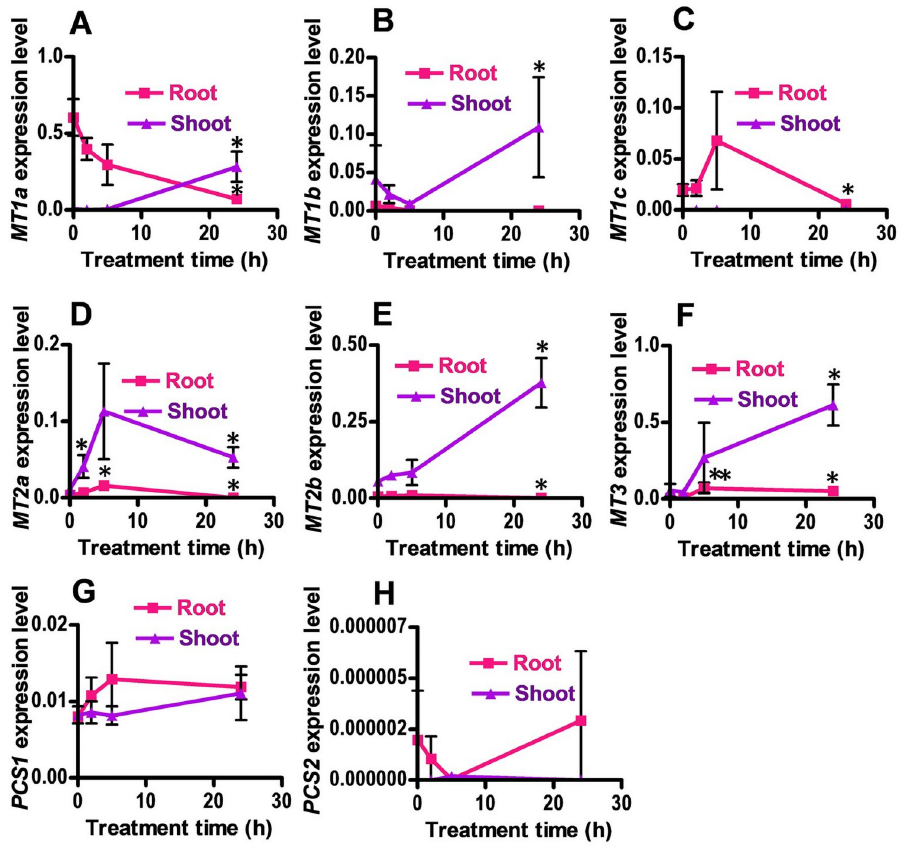
Fig 4. Cd-inducible expression of BrMTs and BrPCSs in B . rapa . One-month old B . rapa plants were treated with 100 μ M CdCl 2 for different times and harvested to analyze the expression levels of B . rapa Cd tolerance genes. qRT-PCRs were performed with cDNA synthesized from the RNA as a template and gene-specific primers (S1 Table). The expression levels of Cd tolerance genes were normalized to the level of actin, and the values indicate the average and standard error (biological replicates: 3). � P < 0.05, �� P < 0.01 (Student’s